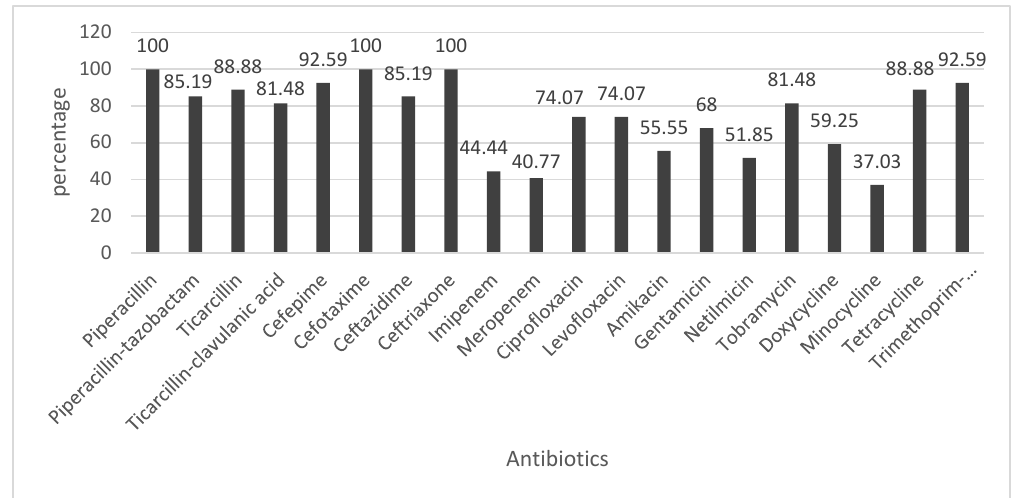
Figure 3. Antibiotic resistance of Acinetobacter baumannii.